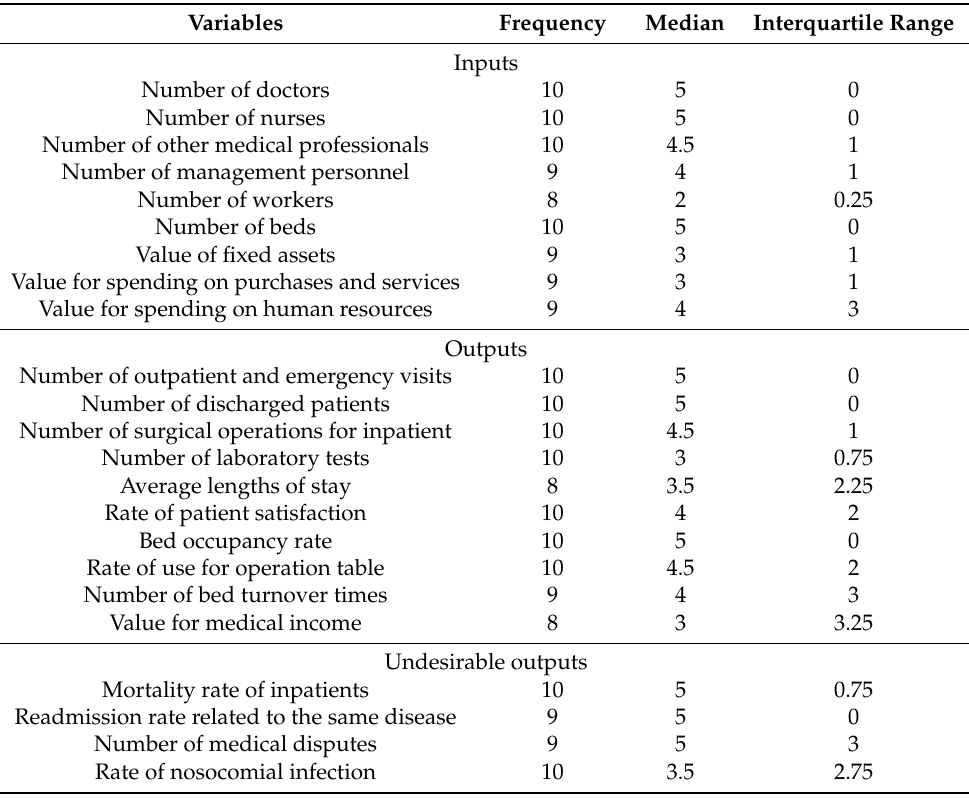
Table 2. Delphi results of candidate variables (2nd